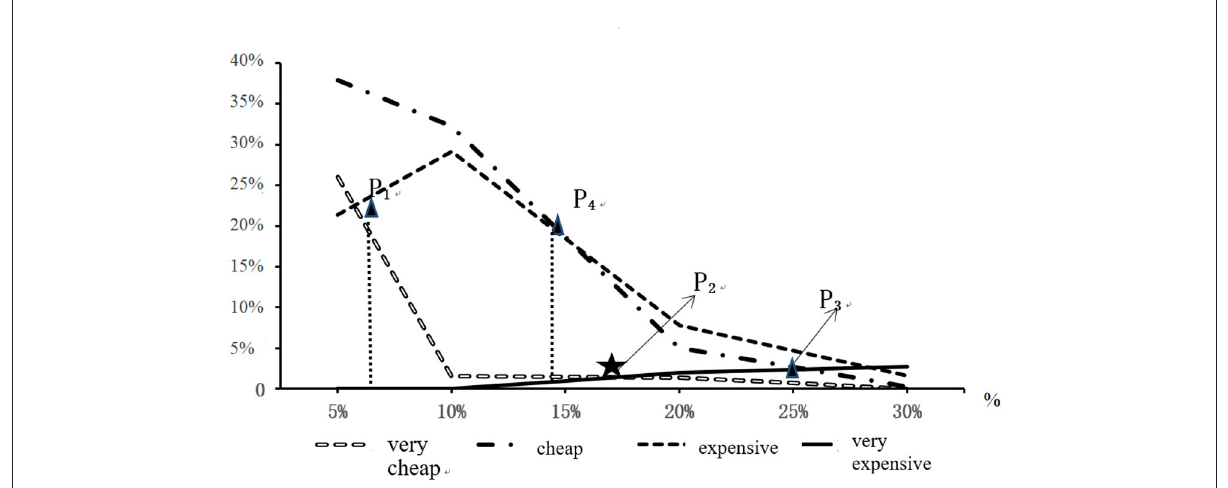
FIGURE4 The sensitivity test for the priority delivery fee accounting for the order cost.